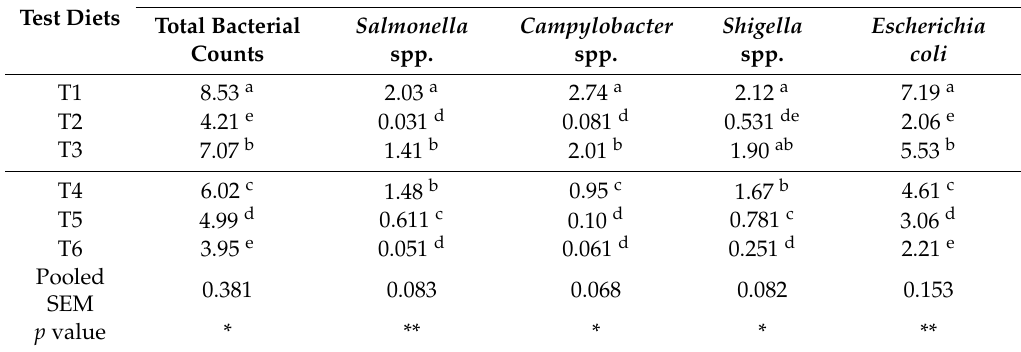
Table 3. Bacterial population densities in gut of broiler chickens fed di ff erent levels of non-degraded and degraded date